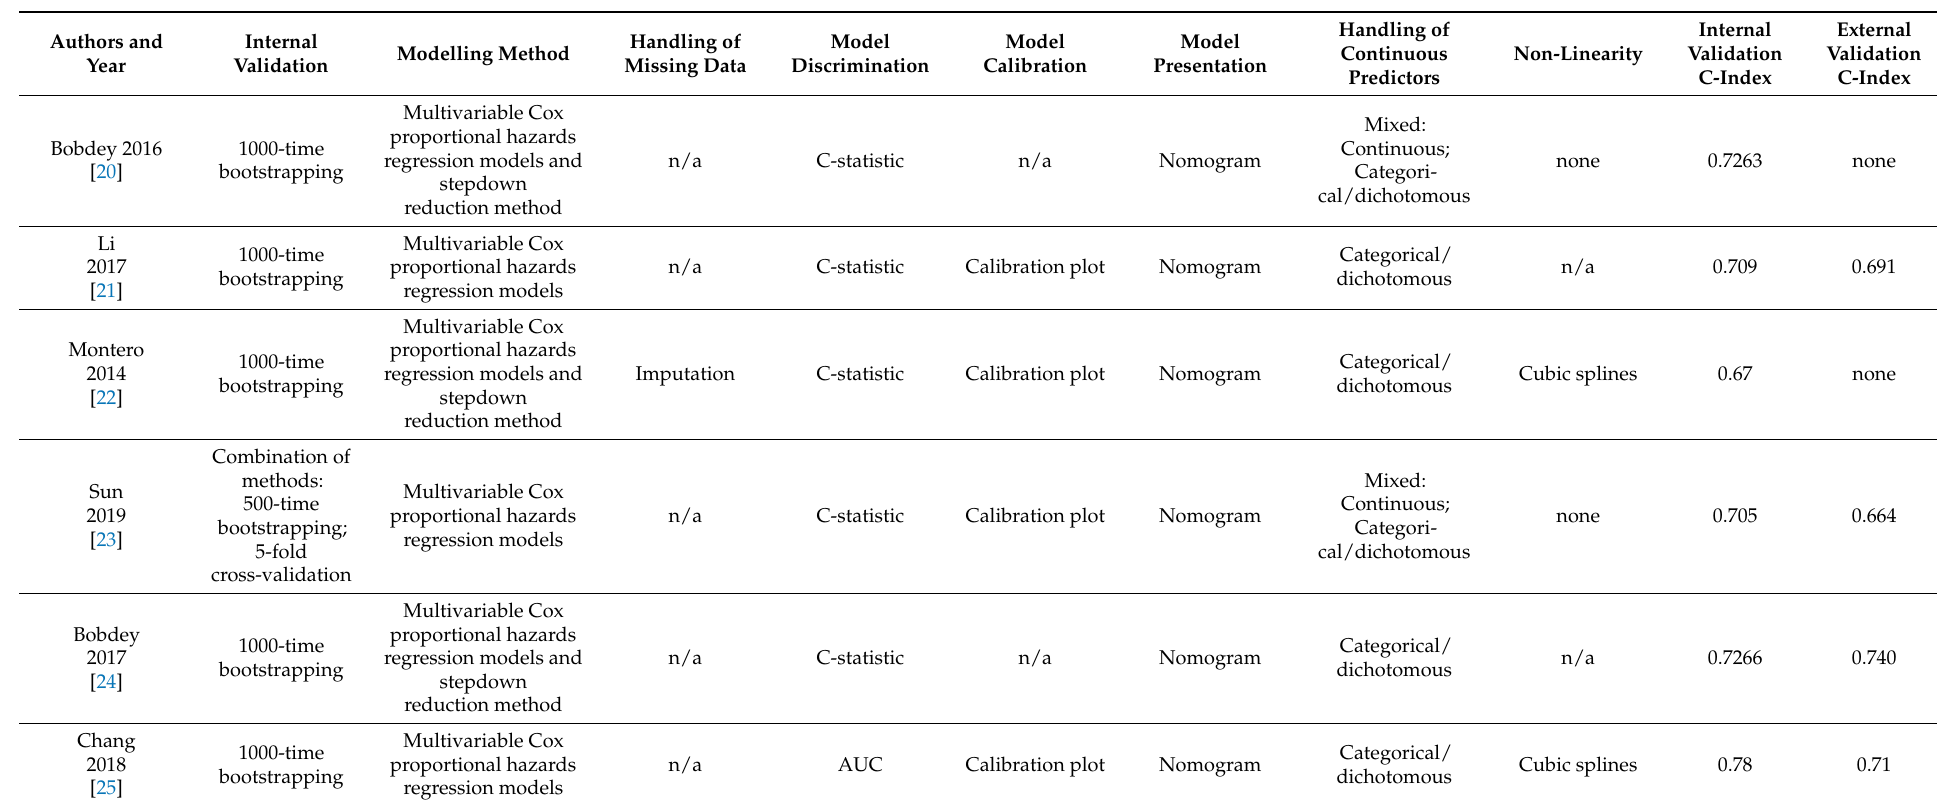
Table 3. Methodological characteristics of prognostic models